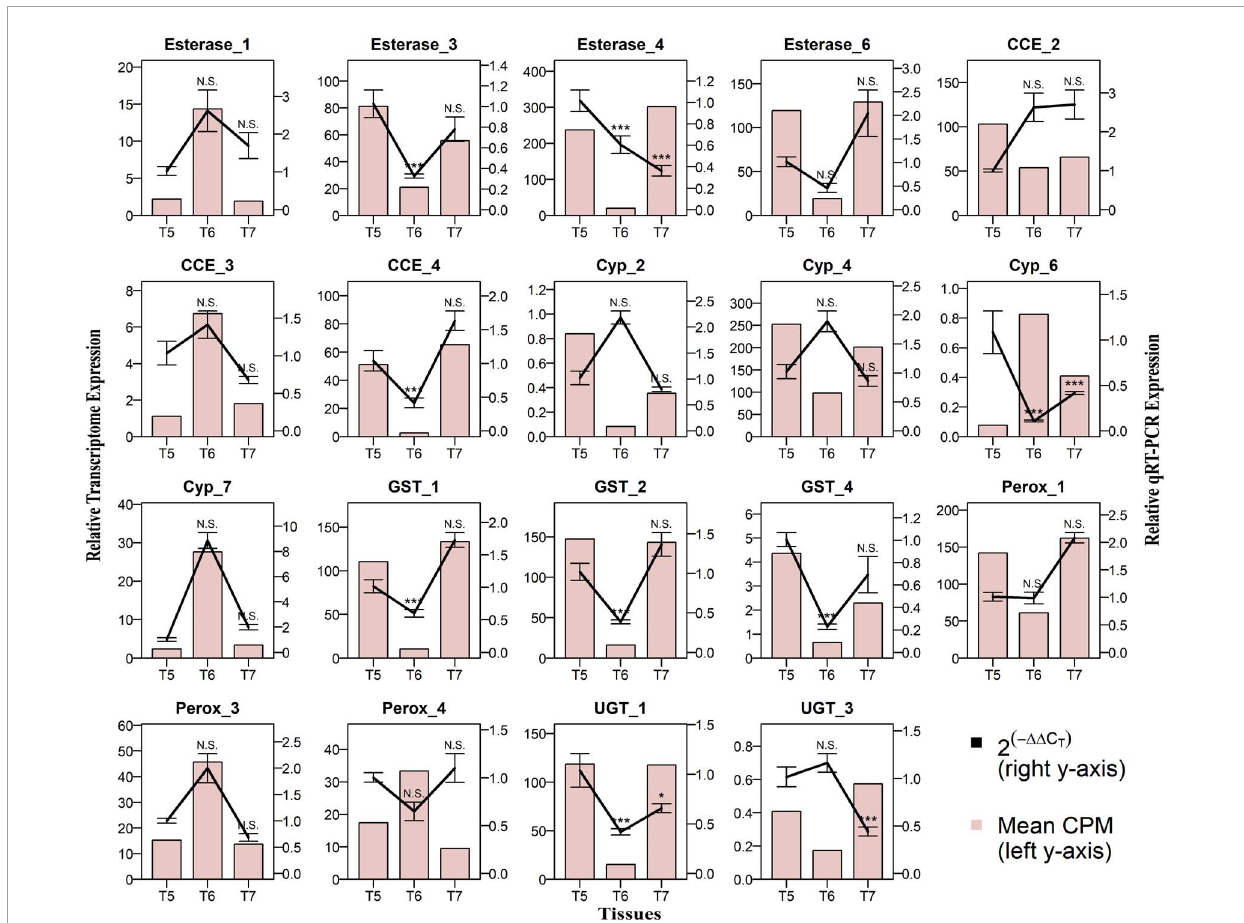
FIGURE12 Comparison of RNA-seq and RT-qPCR data for the relative expression of 19 genes in gut tissues. Callow male gut (T5), sclerotized adult male gut (T6), and callow female gut (T7) on the x -axis plotted against relative expression in RNA seq ( N = 5) represented as mean CPM on the left y -axis and relative expression in RT-qPCR ( N = 4) represented as mean 2ˆ-( (cid:49)(cid:49) Ct) ± S.E. on the right y -axis. The bar graph represents the mean CPM-based expression from RNA-seq transcriptome data, and the solid line represents RT-qPCR expression. Relative expressions in T6 and T7 were compared against those in T5 using Tukey’s HSD with a 95% confidence level, and p -values were generated as per the fit model. * represents p < 0.05, *** represents p < 0.001, and N .S. represents non-significant